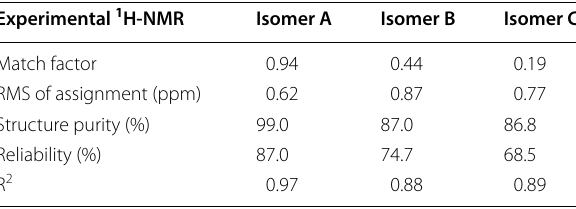
Table 1 Match factor, RMS of assignment, structure purity, reliability, R 2 of possible isomers related to experimental 1 H NMR